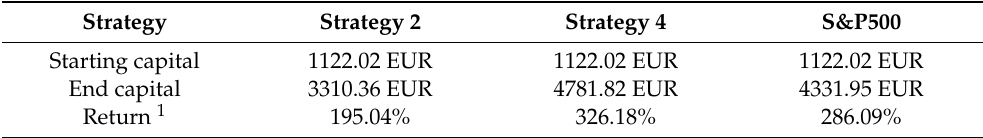
Figure 9. The development of the wealth process of the Strategy 4 (orange) and the portfolio with the constant empirical high-risk asset weights (green). Table 7. The starting and end capital as well as the achieved return during the observation period of the riskier strategies and the S&P500 .